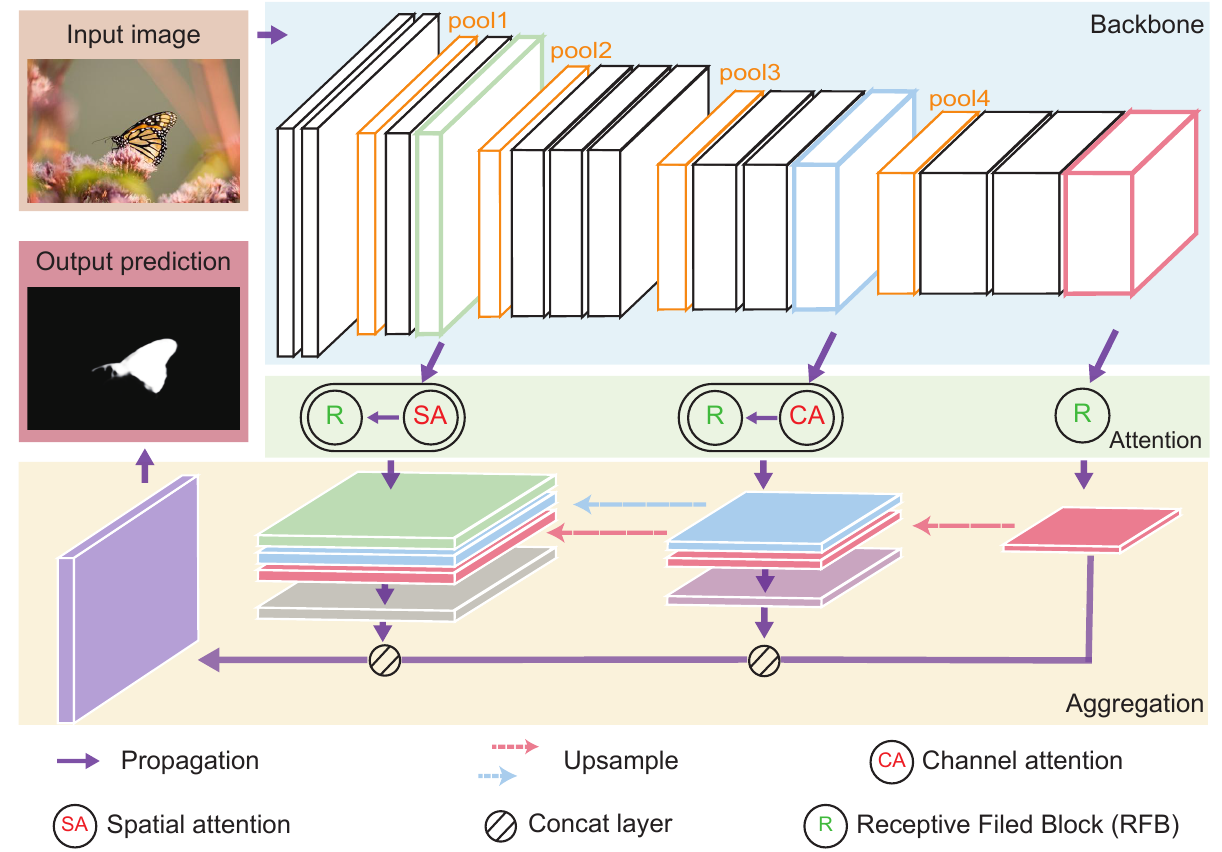
Figure 1. The overall pipeline of the local and global feature aggregation-aware network for salient object detection: